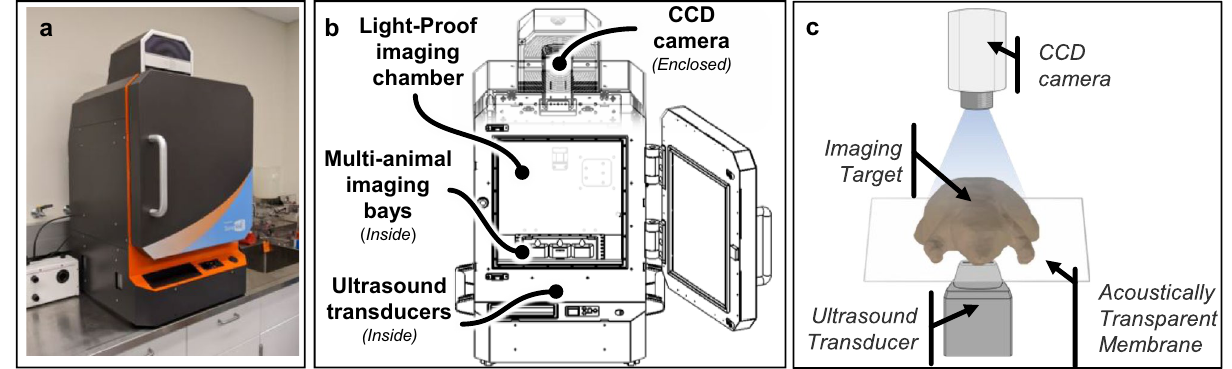
Figure 1. Overview of dual US and BLI imaging system. ( a ) Photo of imaging system. ( b ) Schematic showing the components, including supercooled charge-coupled device (CCD) on top of a light-tight box for BLI and multi-animal bays with anesthesia. ( c ) 3D US volumes are acquired by robotically scanning an ultrasound transducer underneath the animal that is resting on an acoustically transmissive